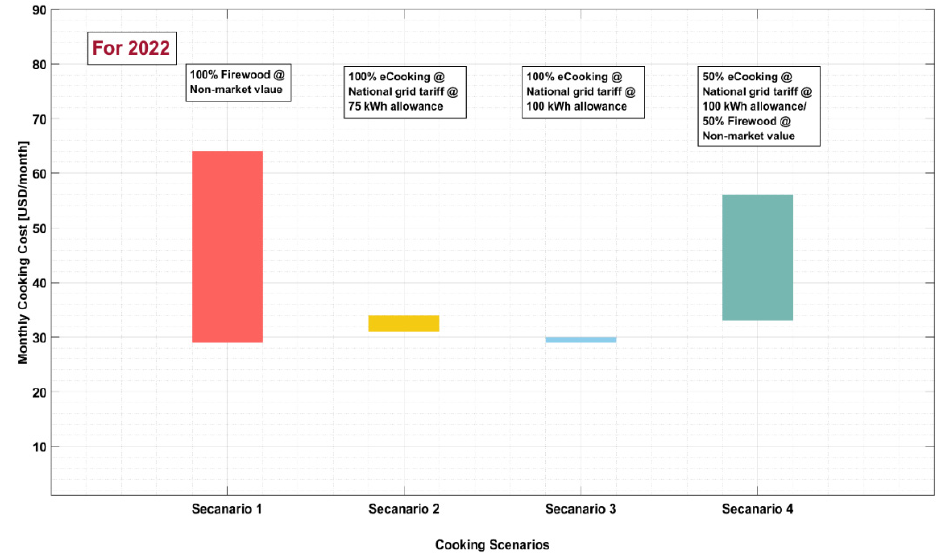
Figure 4. Monthly cooking cost of the contextualized cooking scenarios to close the affordability gap for 2022.